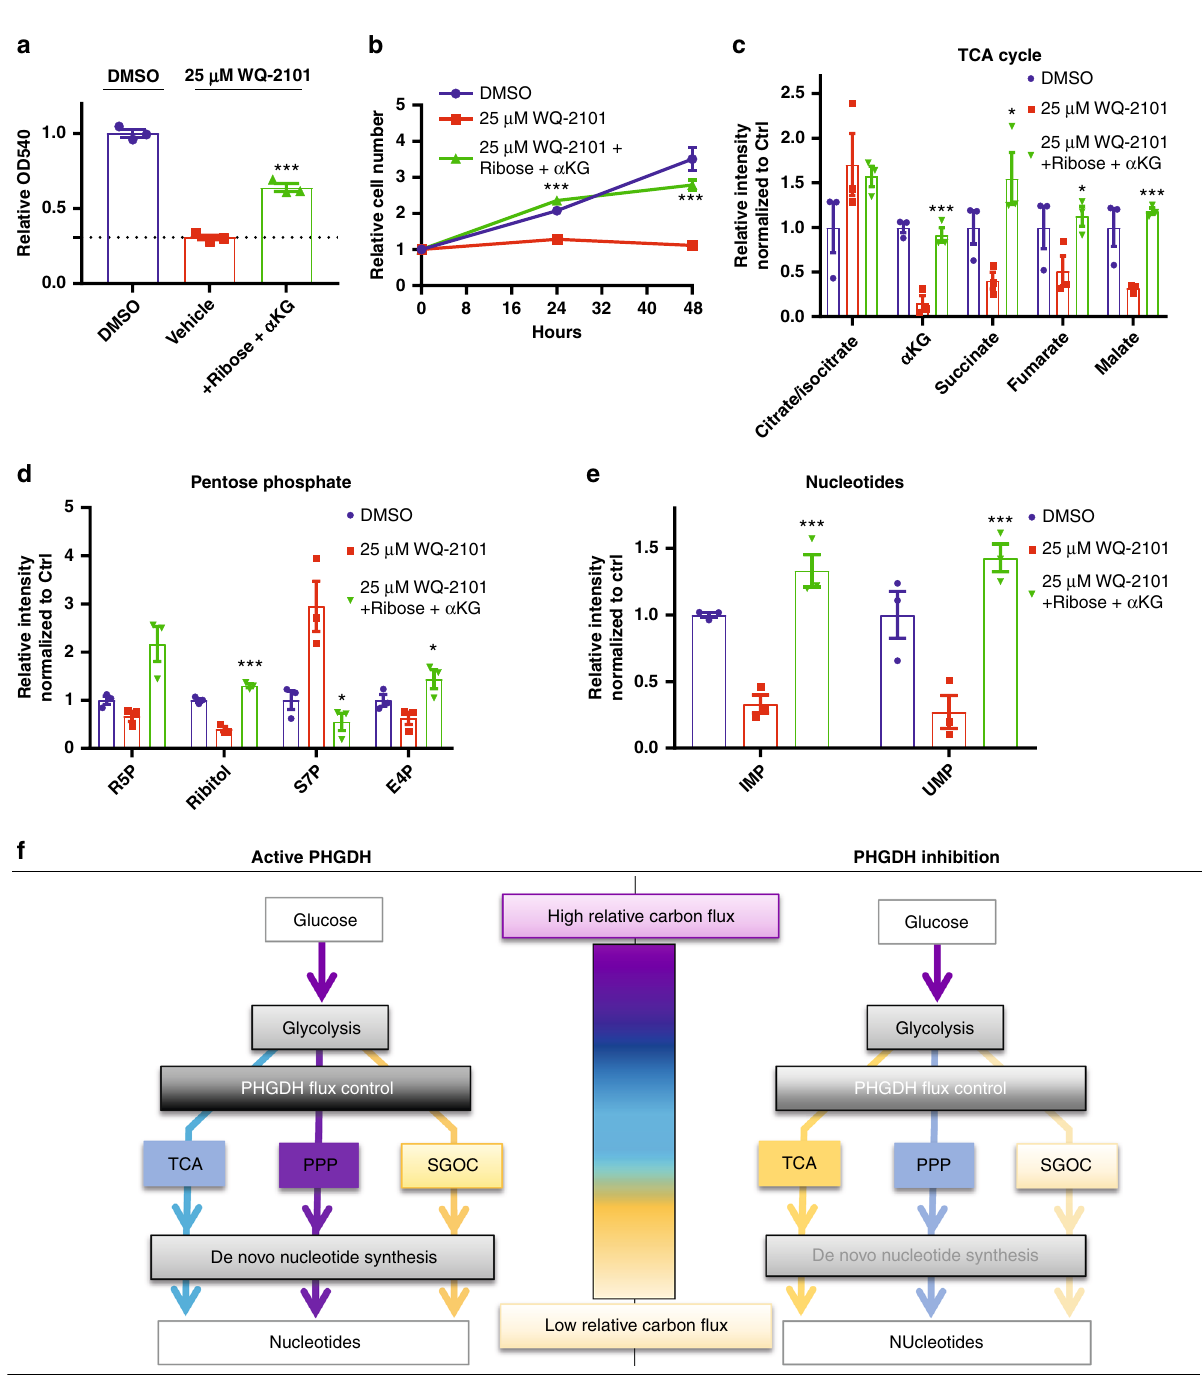
Fig. 6 Restoration of TCA and PPP metabolism rescues cell proliferation during PHGDH inhibition. a MTT assay of cells treated with DMSO control, 25 μ M WQ-2101, or 25 μ M WQ-2101 supplemented with ribose and cell-permeable α KG ( α -ketoglutarate) for 72 h. OD540 values are relative to DMSO control. Data are the mean of three biological replicates, and error bars represent s.e.m. P < 0.005 [***], Student ’ s t -test. b Proliferation assay of cells treated with DMSO control, 25 μ M WQ-2101, or 25 μ M WQ-2101 supplemented with ribose and cell-permeable α KG ( α -ketoglutarate) for indicated time points. Cell number is relative to day of treatment (day 0) per condition. Data are the mean of three biological replicates, and error bars represent s.e.m. P < 0.005 [***], Student ’ s t -test. c Relative integrated peak intensities for TCA cycle-related metabolites. Data are the mean of three biological replicates, and error bars represent s.e.m. P < 0.05 [*], P < 0.01 [**], P < 0.005 [***], Student ’ s t -test. d Relative integrated peak intensities for pentose phosphate pathway metabolites. R5P (ribose-5-phosphate); S7P (sedoheptulose-7-phosphate); E4P (erythrose-4-phosphate). Data are the mean of three biological replicates, and error bars represent s.e.m. P < 0.05 [*], P < 0.005 [***], Student ’ s t -test. e Relative integrated peak intensities for IMP (inosine monophosphate) and UMP (uridine monophosphate). Data are the mean of three biological replicates, and error bars represent s.e.m. P < 0.01 [**], Student ’ s t -test. f Schematic for how PHGDH regulates glucose carbon fl ux control (left) and effects on these fl ux controls upon its inhibition (right). TCA (TCA cycle); PPP (pentose phosphate pathway); SGOC (serine, glycine, one-carbon metabolism). Purple to yellow color scale indicates high to low relative carbon fl ux through a